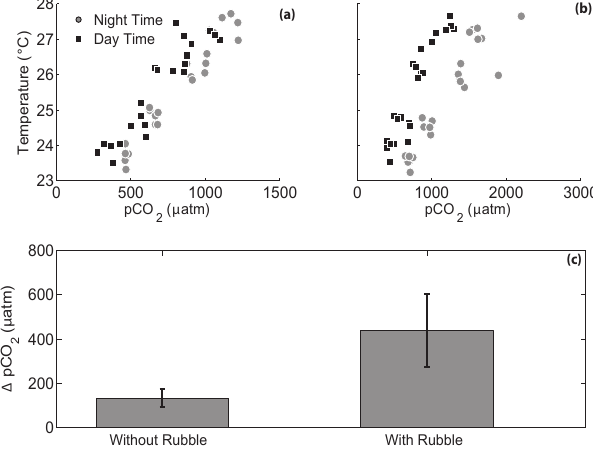
Figure 2. p CO 2 and temperature in each aquarium (a) without any rubble present and (b) with rubble present. Daily variability in p CO 2 was higher when rubble was present due to feedbacks from the rubble community (note the different x axis scales in panels (a) and (b) ). Panel (c) shows the mean difference between day and night p CO 2 with and without rubble present, with observations paired by aquarium (error bars are standard error) ( t 23 = − 7.23, p